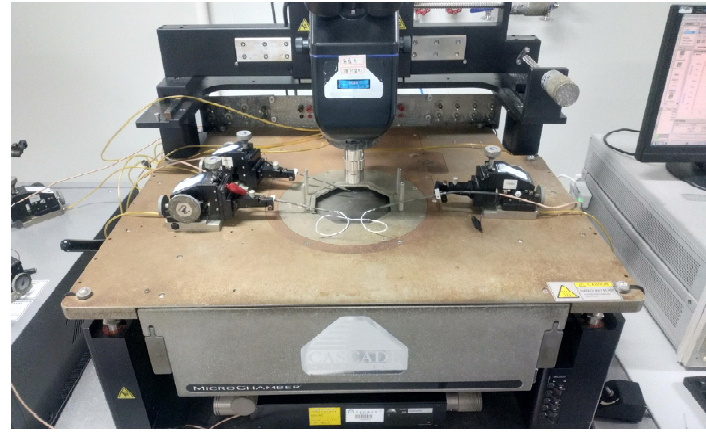
Figure 5. The I-V static parameter test layout of the 2CZ106C.